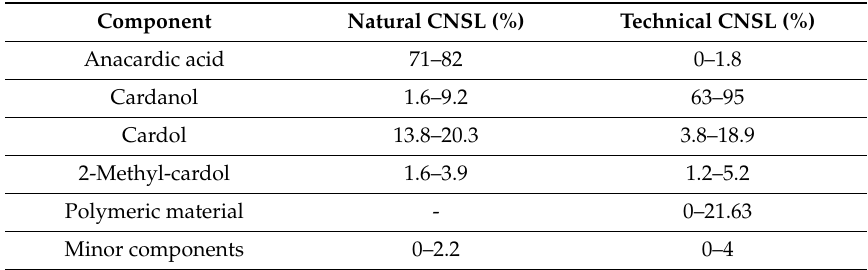
Table 1. Components of natural and technical CNSL